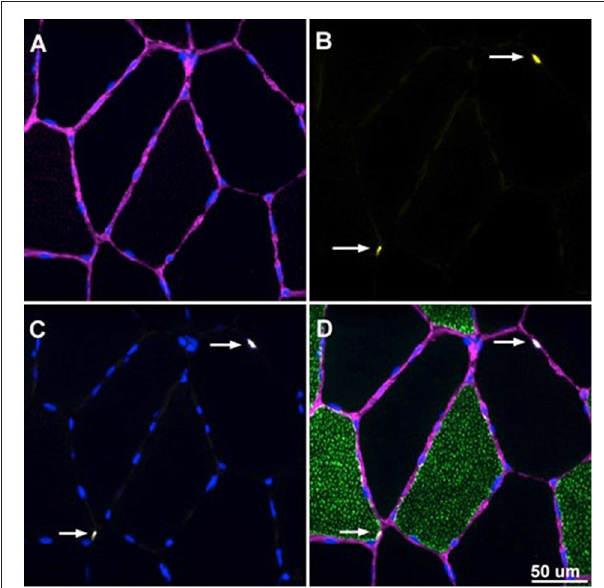
Figure 2 . Note that fiber CSA from 7 of the 8 subjects in